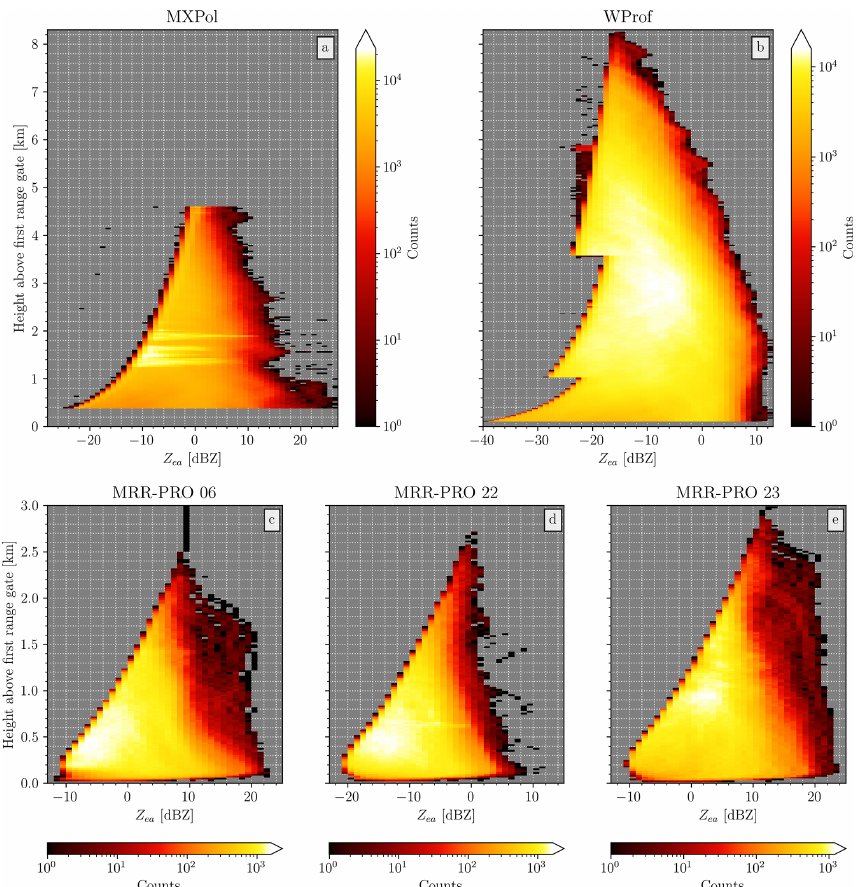
Figure 4. Two-dimensional histogram of the horizontal reflectivity factor collected by MXPol during the vertical scans (a) , and the equivalent reflectivity factor recorded by WProf (b) , MRR-PRO 06 (c) , MRR-PRO 22 (d) , and MRR-PRO 23 (e) . A minimum threshold of 0dB has been imposed on SNR for all the